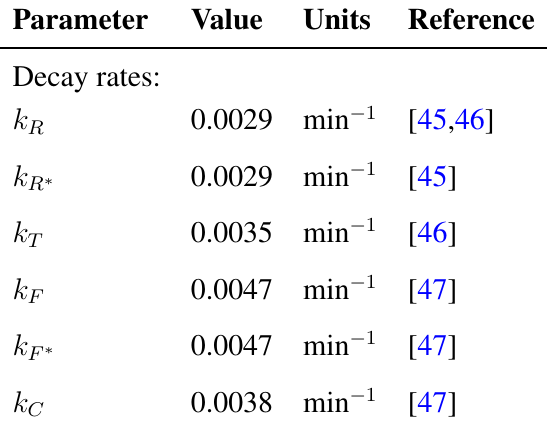
Table 4. Default parameter settings for simulations: subcellular level (Key: M,